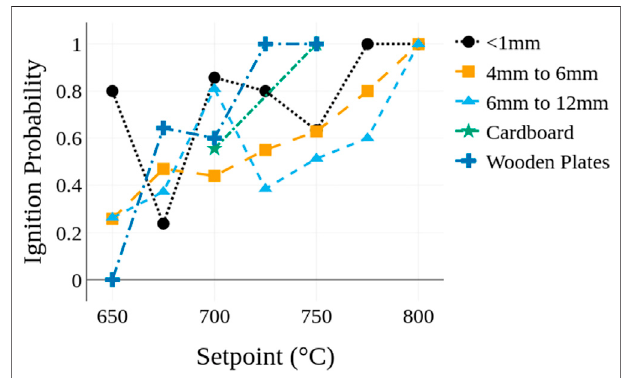
FIGURE6| Probabilityofignitionforeachmaterialasafunctionofheater set point temperature.